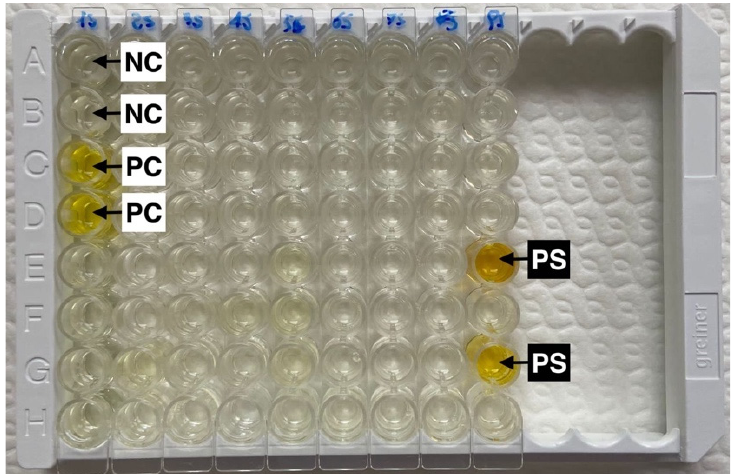
Figure 2. Double antigen ELISA that detects specific anti-SARS-CoV-2 nucleocapsid (N-Protein) antibodies (ID-Screen ® ELISA, SARS-CoV-2 double antigen multi-species, ID.vet, France). Two positive cat serum samples (PS, positive sample) show a sample/positive control (PC) ratio greater than 60%. The negative serum sample controls are indicated as NC (negative control).